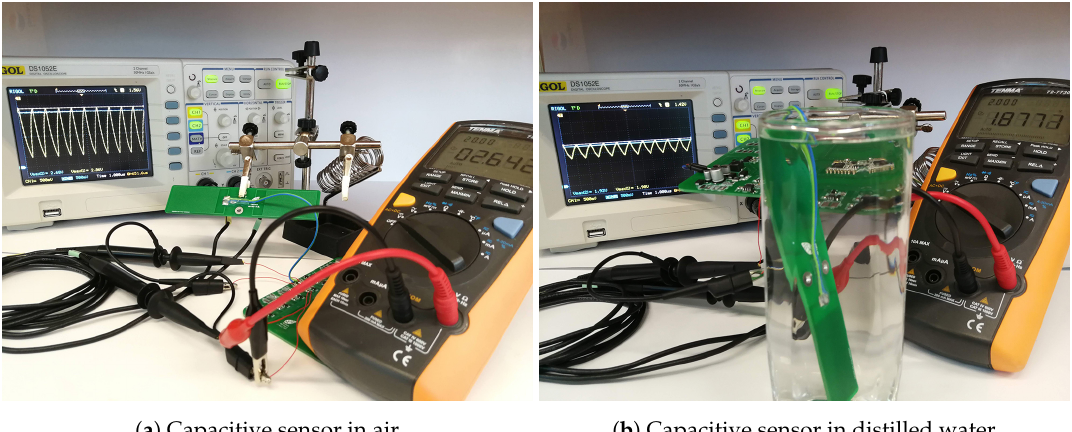
Figure 9. Capacitance measurement circuit investigation setup. A RIGOL DS1052E oscilloscope has CH1 connected to the AC voltage of the capacitor sensor and CH2 connected next to a TENMA 72-7730A Digital Multimeter at the DC output voltage from the peak detector